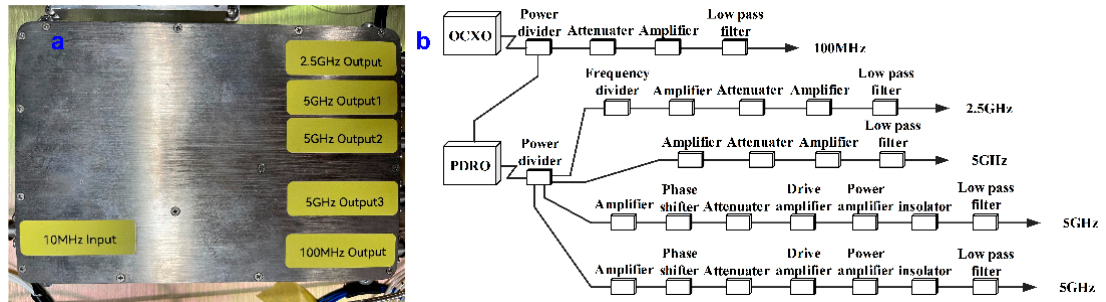
Figure 6. Photographs of the microwave source employed in the OFC generation. ( a ) Exterior ap- pearance. ( b ) Internal architecture.